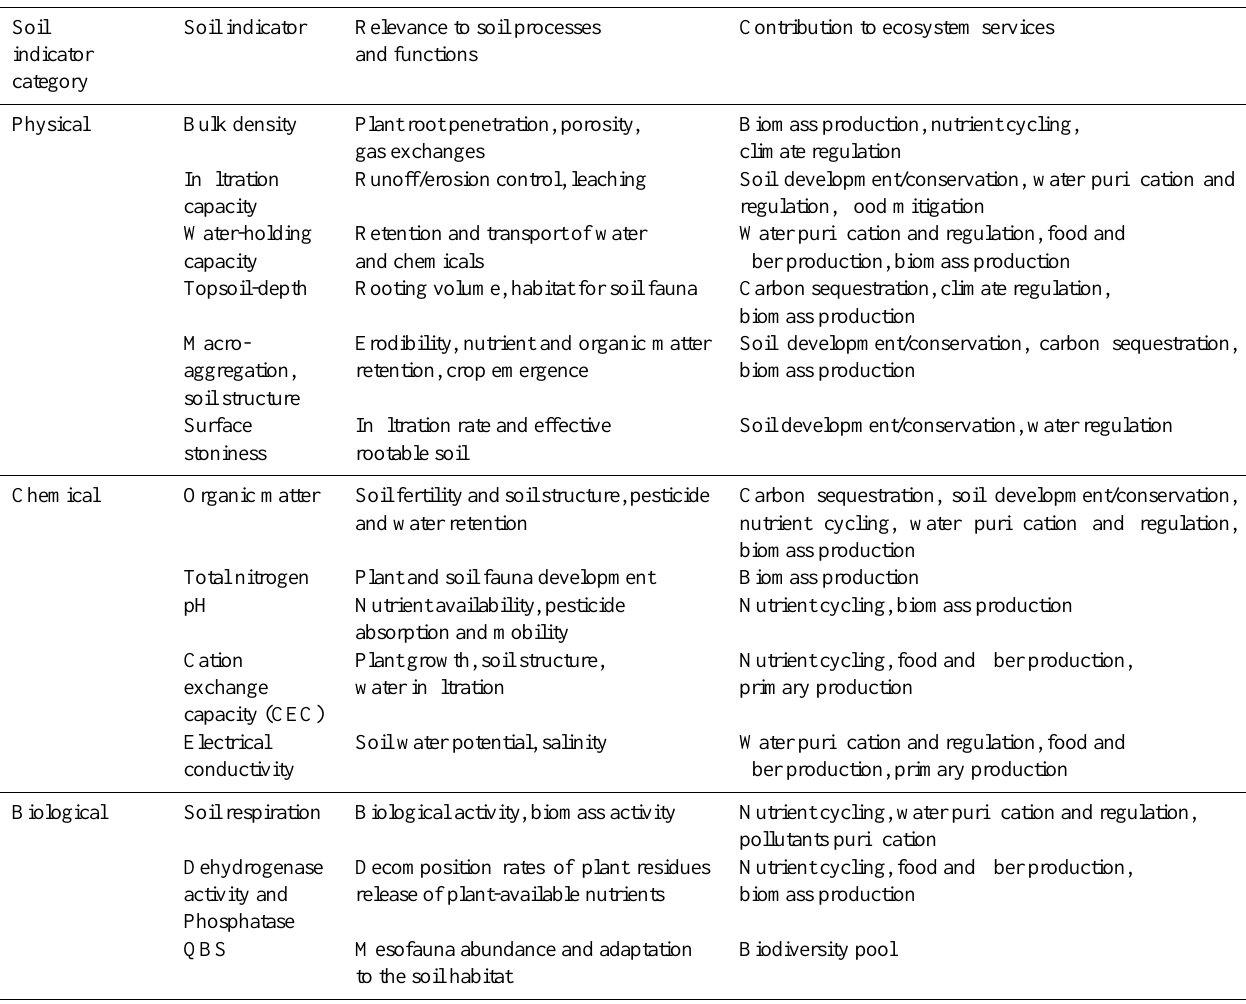
Table 2. Example of soil indicators used in restoration.